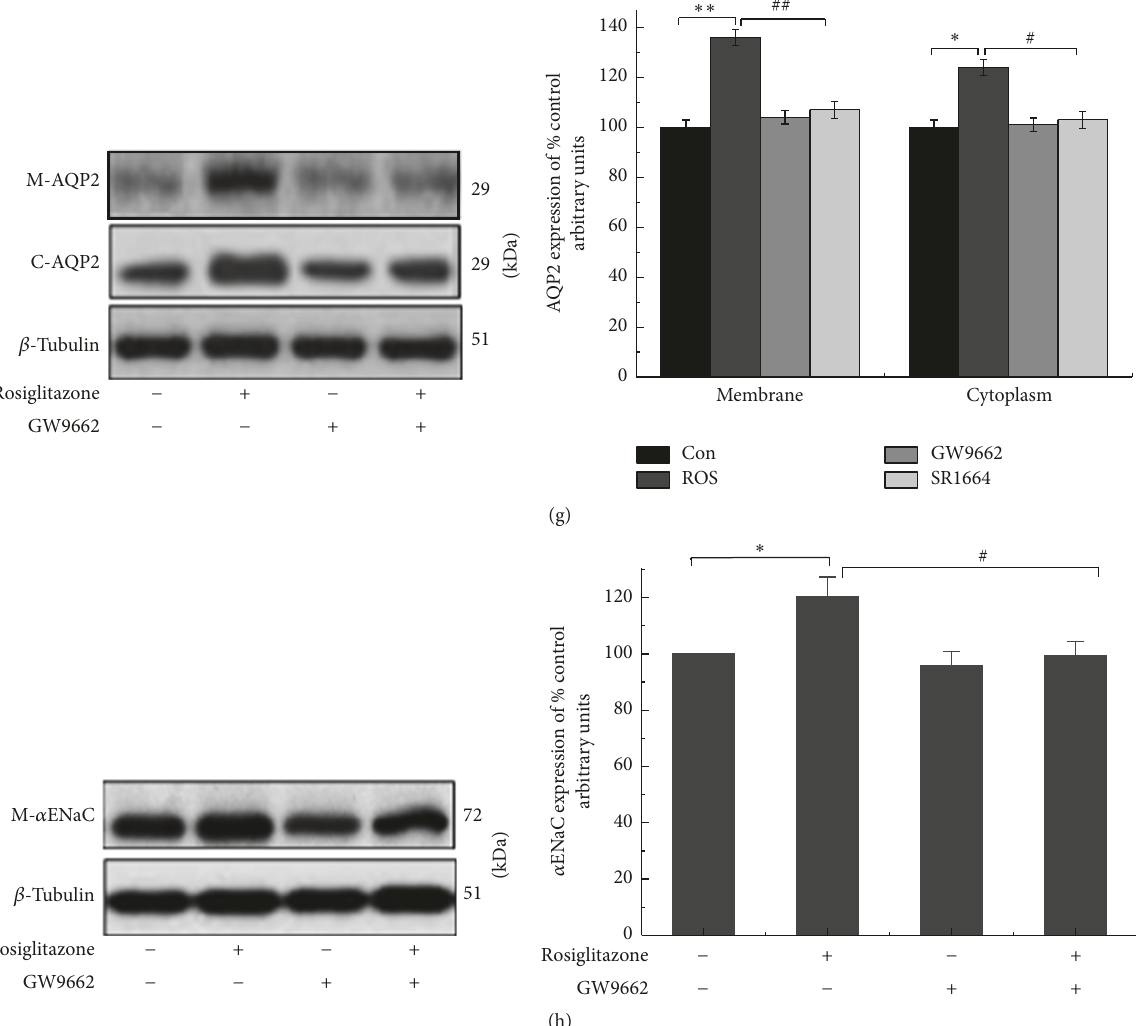
Figure 4: Effects of rosiglitazone and coincubation with GW9662 in mIMCD-3 cells. (a–d) The effects of rosiglitazone on PPAR 𝛾 , p-PPAR 𝛾 , AQP2, and 𝛼 ENaC. (e–h) The changes of PPAR 𝛾 , p-PPAR 𝛾 , AQP2, and 𝛼 ENaC upon coincubation with GW9662 (10 𝜇 M ROS + 5 𝜇 M GW9662). The results show that rosiglitazone at 10 𝜇 M can significantly decrease total and nuclear p-PPAR 𝛾 but critically upregulated nuclear PPAR 𝛾 and AQP2 and 𝛼 ENaC membrane transpositions. After coincubation with GW9662 (10 𝜇 M ROS + 5 𝜇 M GW9662), the effects of rosiglitazone on PPAR 𝛾 , p-PPAR 𝛾 , AQP2, and 𝛼 ENaC disappeared. The results are shown as mean ± s.e.m., 𝑛 = 3 . ∗/ # 𝑃 < 0.05 . ∗∗/ ## 𝑃 < 0.01 . ∗ means compared to control; # means compared to